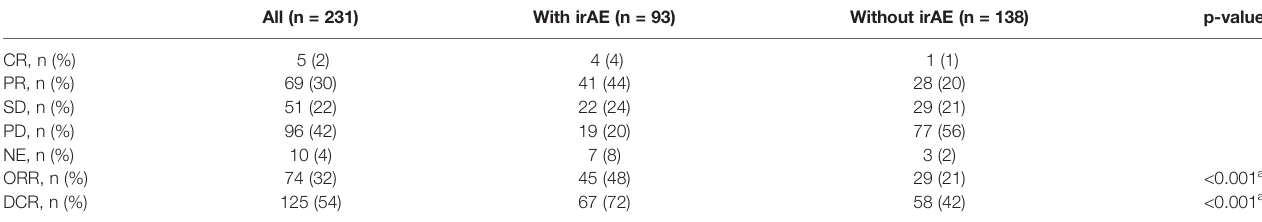
TABLE 3 | Association between irAEs and treatment responses. All (n =